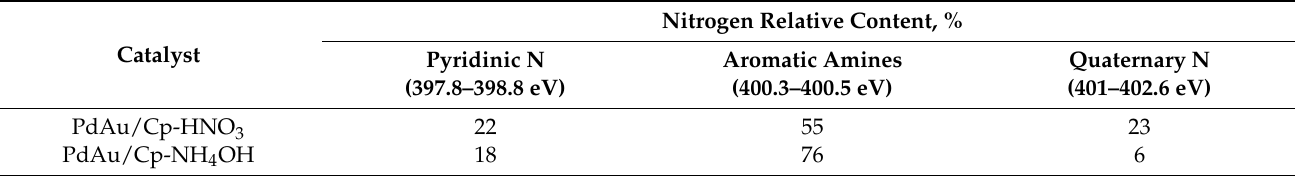
Table 9. Effect of modification of support on contribution of different species of nitrogen calculated according to XPS.